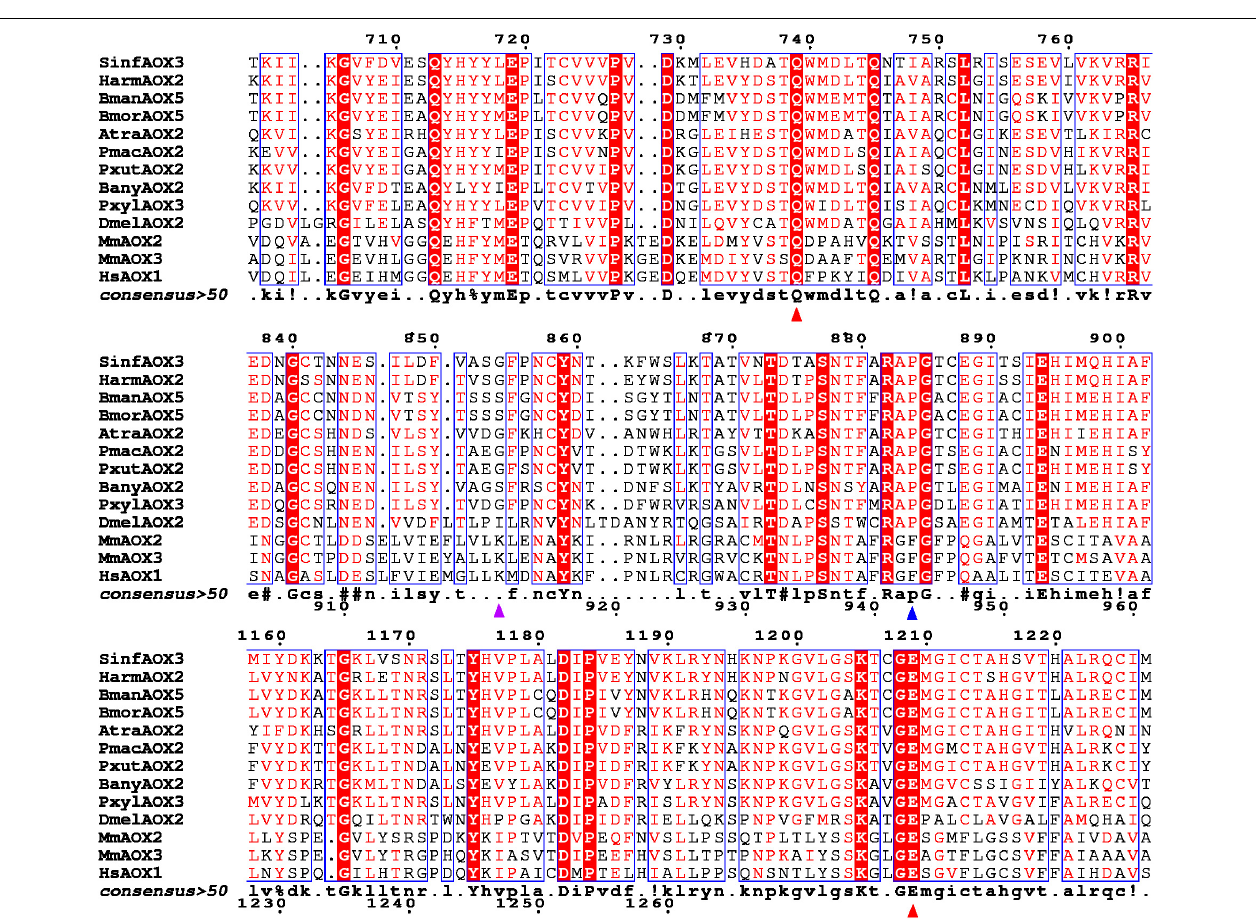
FIGURE 3 | Fragment of a multiple sequence alignment between vertebrate and invertebrate AOXs. Identical residues are highlighted in white letters with red background. Similar residues are highlighted in red and framed in blue. Triangles indicate conserved sites according to Terao et al. (2020). Red triangles show conserved residues across all analyzed species. Blue triangle shows residue conserved only in insect species. Purple triangle shows an active site with different residues within Lepidoptera species. Full alignment can be found in Supplementary Figure 1